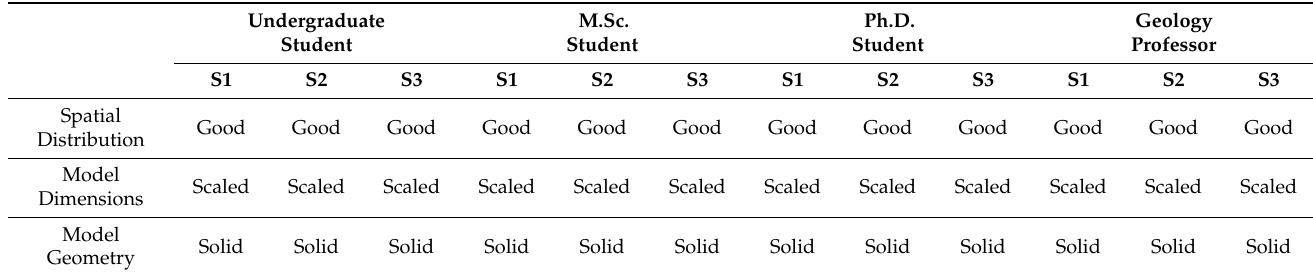
Table 9. Qualitative analysis after the methodological procedures.